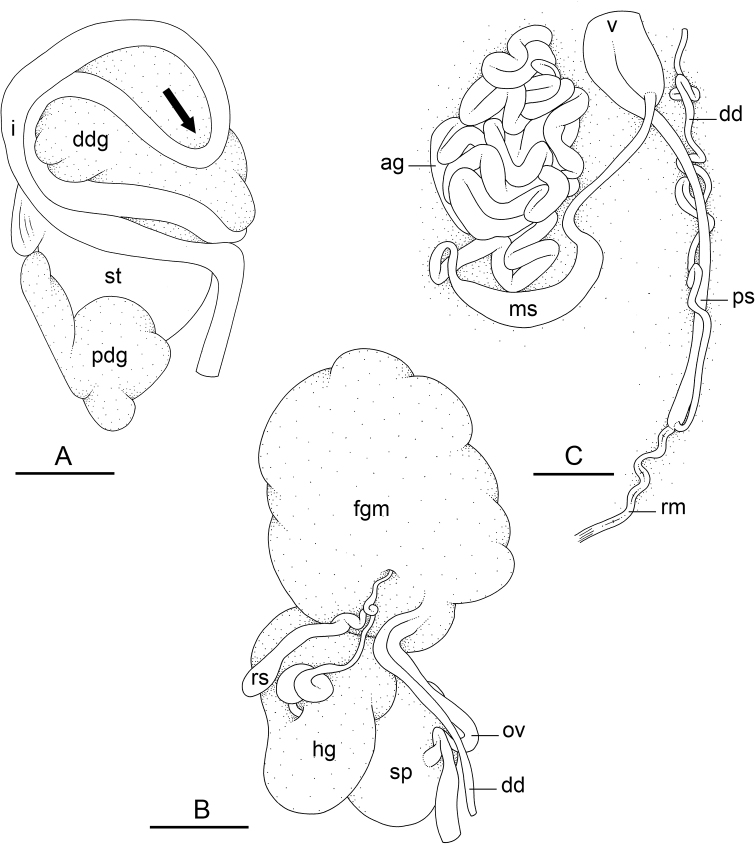
Peronia
verruculata (unit #3), Peninsular Malaysia, Langkawi, [976] (USMMC 00051) A digestive system, dorsal view, the arrow indicates the orientation of the transitional loop B posterior, hermaphroditic (female) reproductive system C anterior, male, copulatory apparatus. Scale bars: 5 mm (A), 3 mm (B), 4 mm (C). Abbreviations: ag accessory penial gland, dd deferent duct, ddg dorsal digestive gland, fgm female gland mass, hg hermaphroditic gland, i intestine, ms muscular sac, ov oviduct, pdg posterior digestive gland, ps penial sheath, rm retractor muscle, rs receptaculum seminis, sp spermatheca, st stomach, v vestibule.